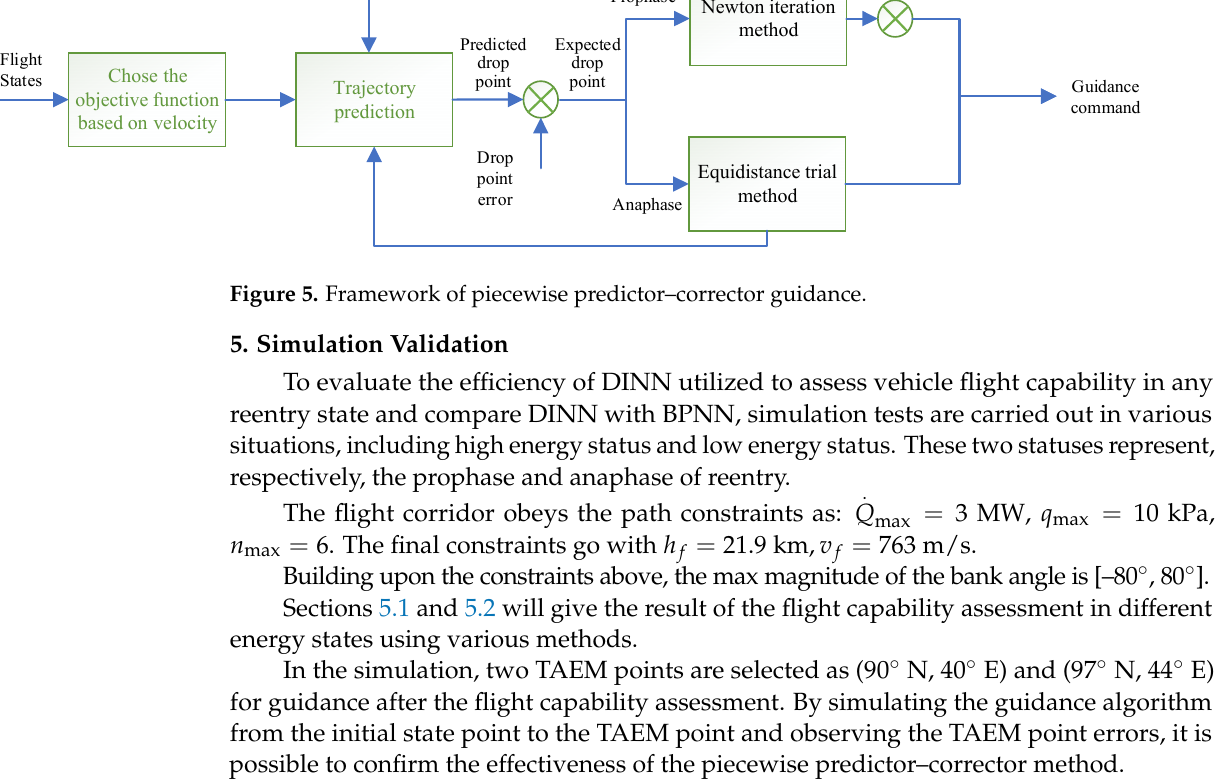
Table 5. Four cases in high energy